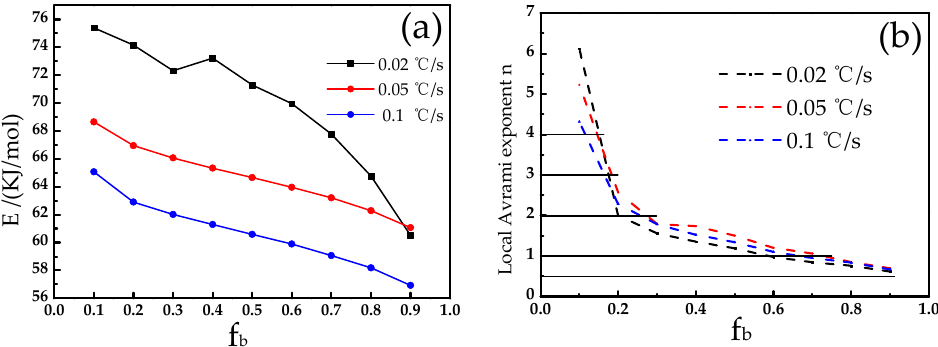
Figure 12. ( a ) Relationship between local activation energy and volume fraction of bainite transfor- mation, ( b ) relationship between local Avrami exponent and the bainite transformed volume frac- tion.